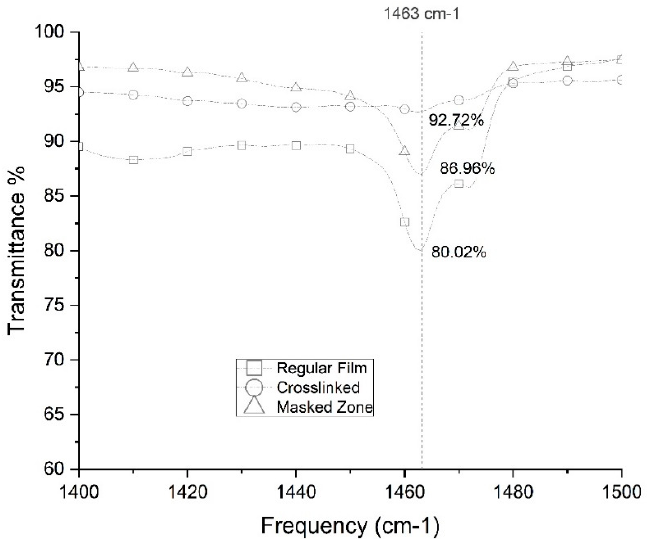
Figure 6. FTIR comparing regular LLDPE film and masked and stabilized film in a 1400 cm − 1 to 1500 cm − 1 range.